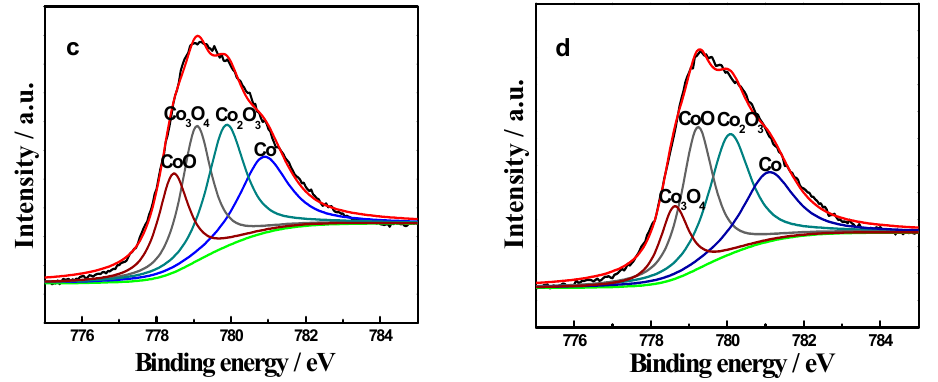
Figure 4. Analysis of Co2p 3/2 on composite metal ‐ oxide catalysts ( a ) Co 3 O 4 ; ( b ) Mg 0.2 Co 0.8 Co 2 O 4 ; ( c ) Ce 0.05 Co 0.95 Co 2 O 4 ; ( d ) Mg 0.025 Ce 0.05 Co 0.925 Co 2 O 4 .